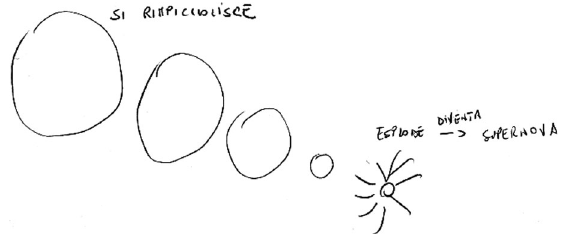
FIG. 6. Student sketch of a star ’ s life stages. Translation of Italian labels, from left to right: [it] becomes smaller, explodes – becomes